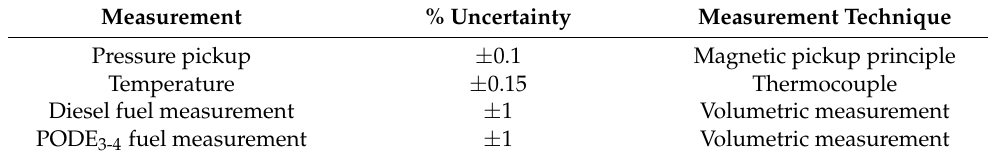
Figure 1. Schematic of the constant volume combustion chamber system. Table 1. Uncertainties and experimental measurement techniques/instruments.